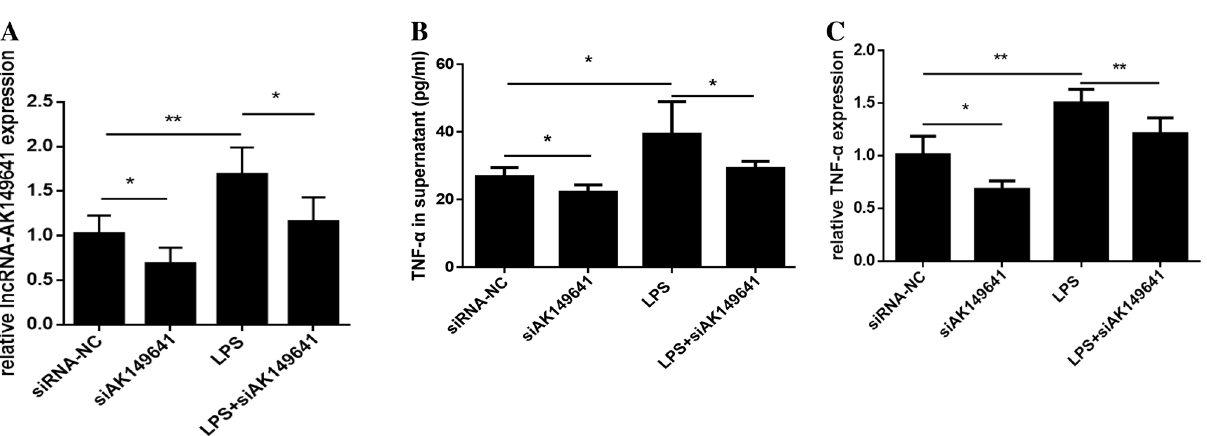
Figure 3. Effect of lncRNA-AK149641 on the LPS-induced secretion of TNF-α. ( A ) Effects of LPS stimulation and siRNA transfection on the expression of lncRNA-AK149641 in P815 mast cells. Effects of LPS stimulation and siRNA transfection on the secretion of TNF-α, determined by ( B ) ELISA and ( C ) qRT-PCR (* P < 0.05, ** P < 0.01, n =